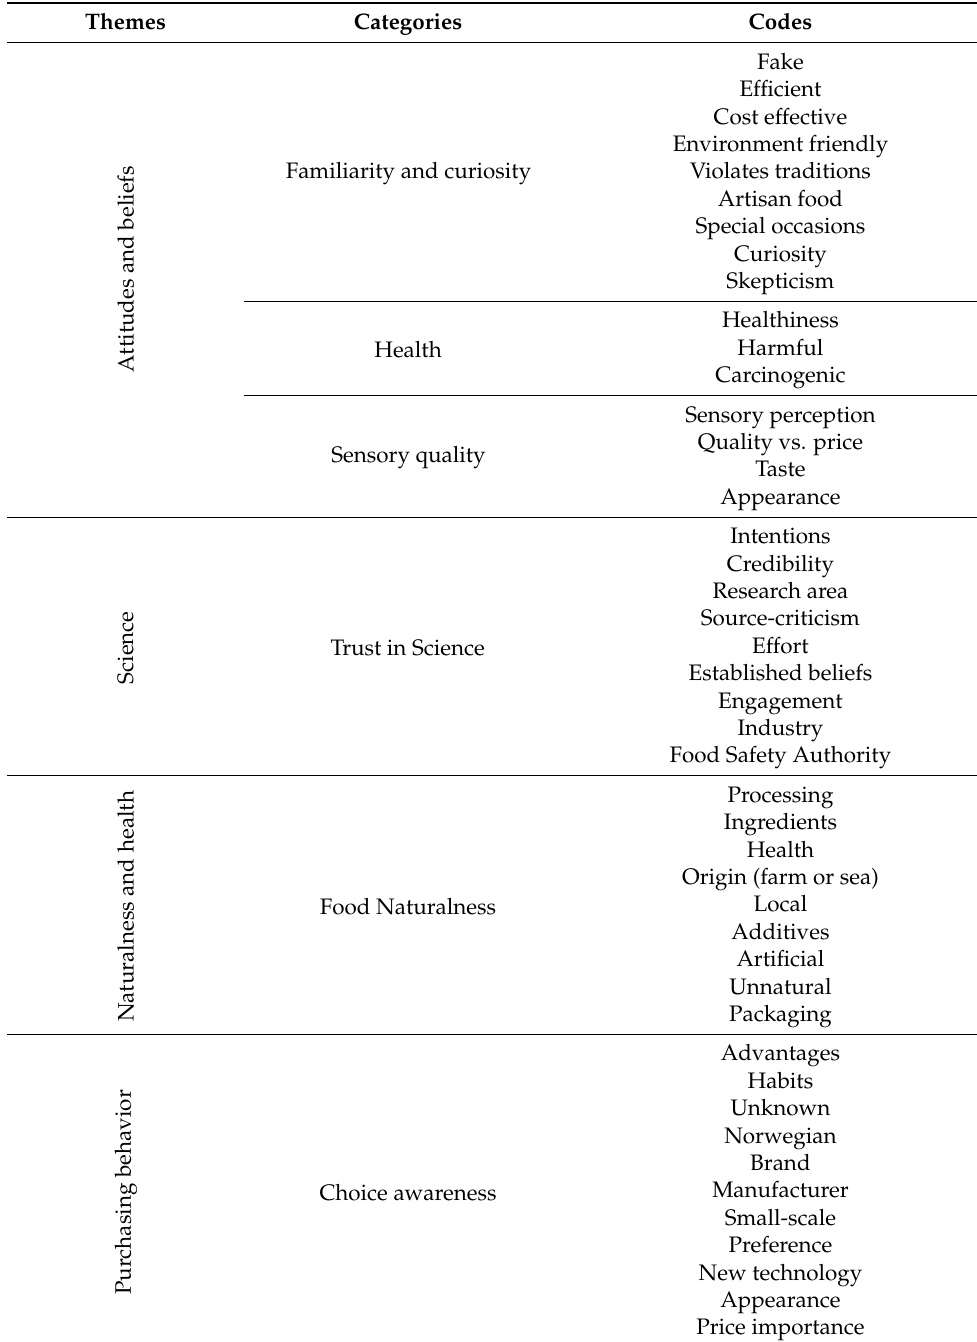
Table 5. Themes, categories, and